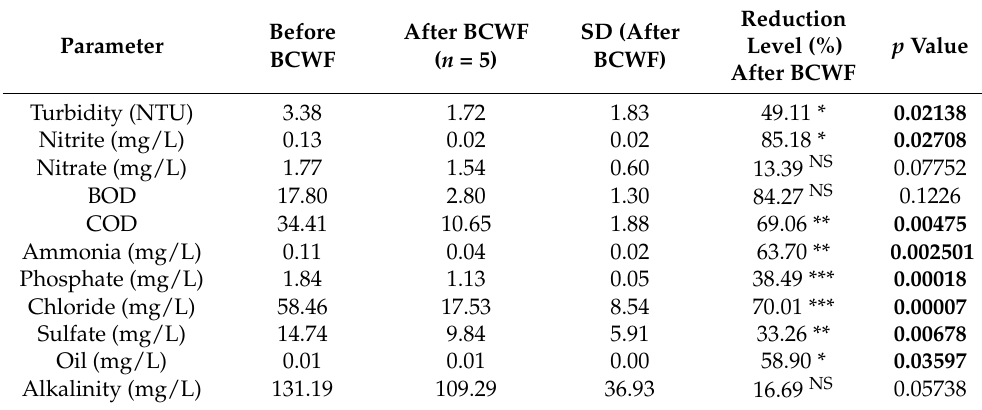
Table 1. BCWF bacteria-removal assay with natural water testing, physicochemical removal in filtered water on the basis of drinking water guidelines